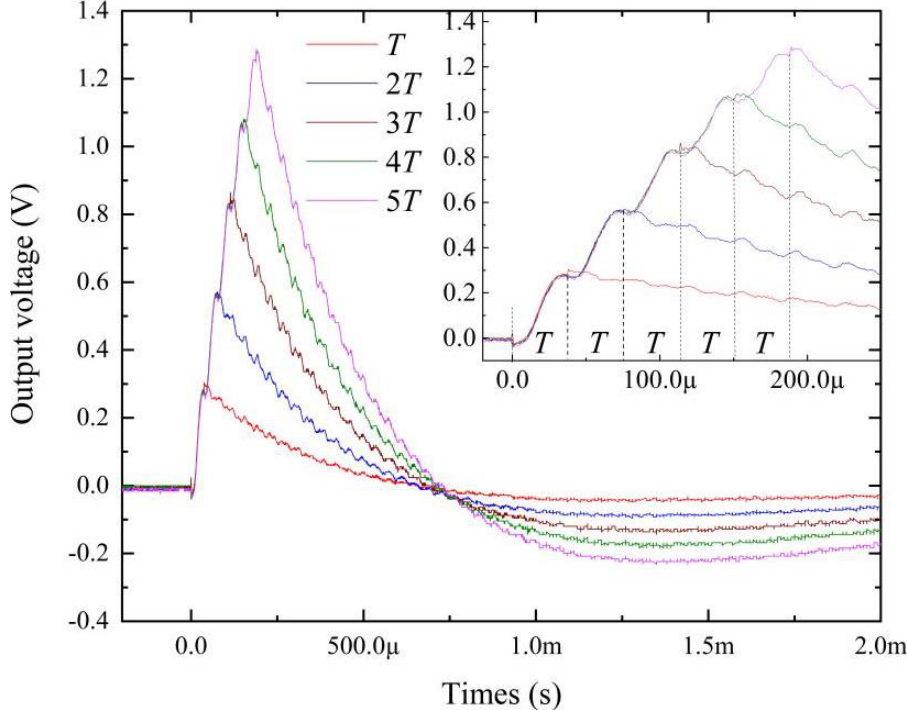
Figure 4. Time dependence output voltage V o of the FeCuNbSiB/piezofiber structure driven by the magnetic field pulse with an amplitude of 51 Oe and a width of Δ t = T – 5T. The rise time of the pulse magnetic was ~8.4 ns. The bias magnetic field was set to zero.